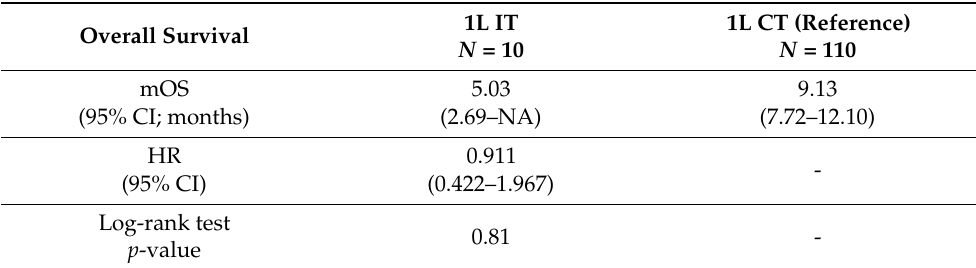
Table A3. Survival outcomes from start date of therapy for first-line palliative immunotherapy and